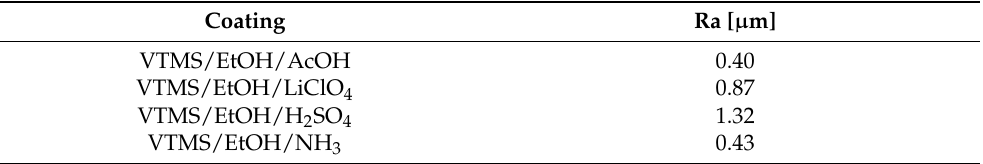
Table 4. Roughness parameter Ra for individual coatings deposited on steel X20Cr13.